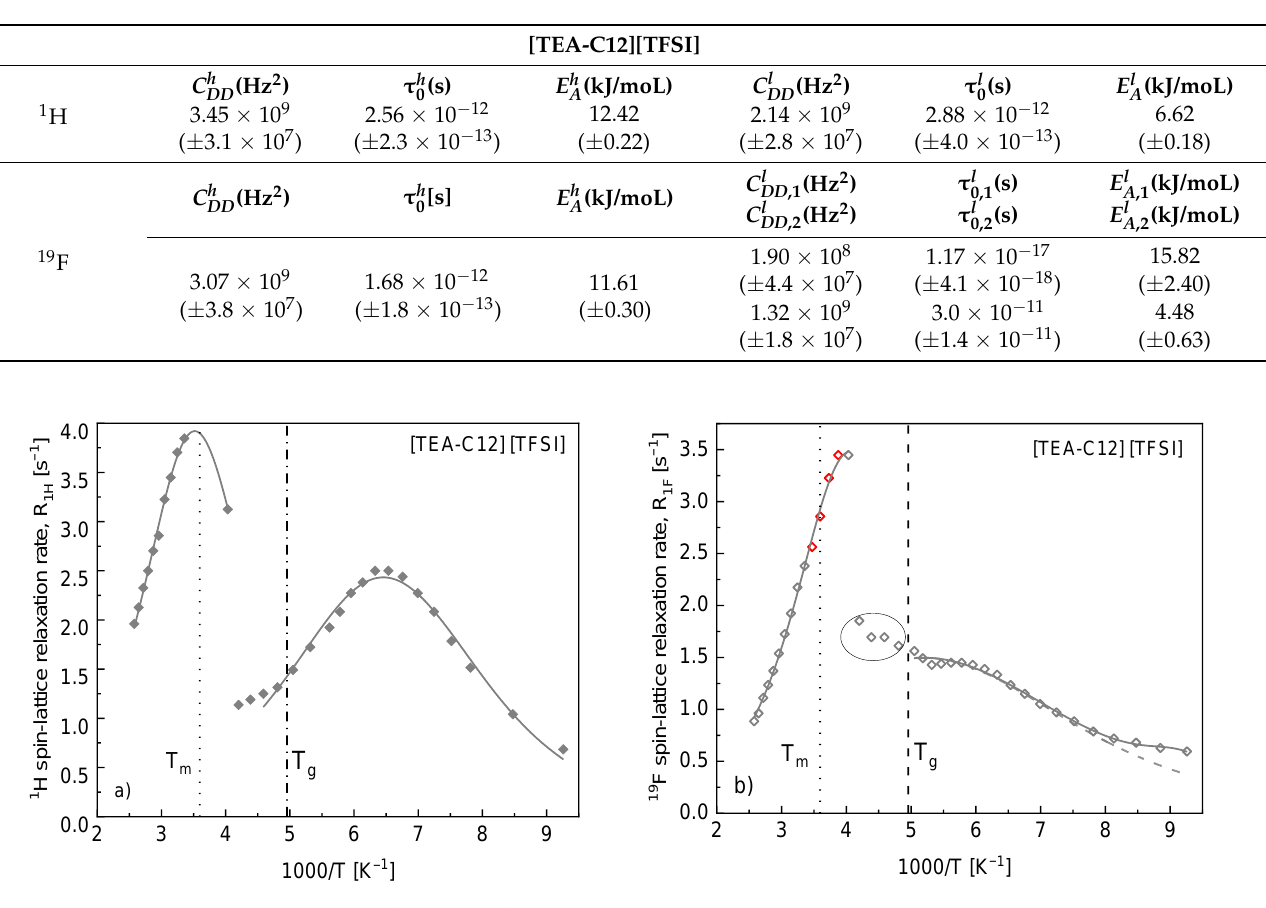
Table 3. Parameters obtained from the analysis of the 1 H and 19 F spin-lattice relaxation data for [TEA-C12][TFSI].